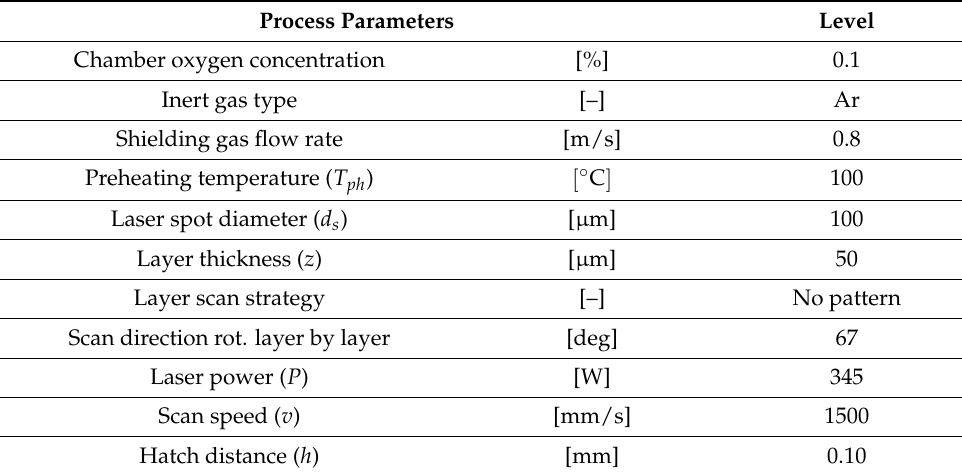
Table 3. Overall volume LPBF process parameters